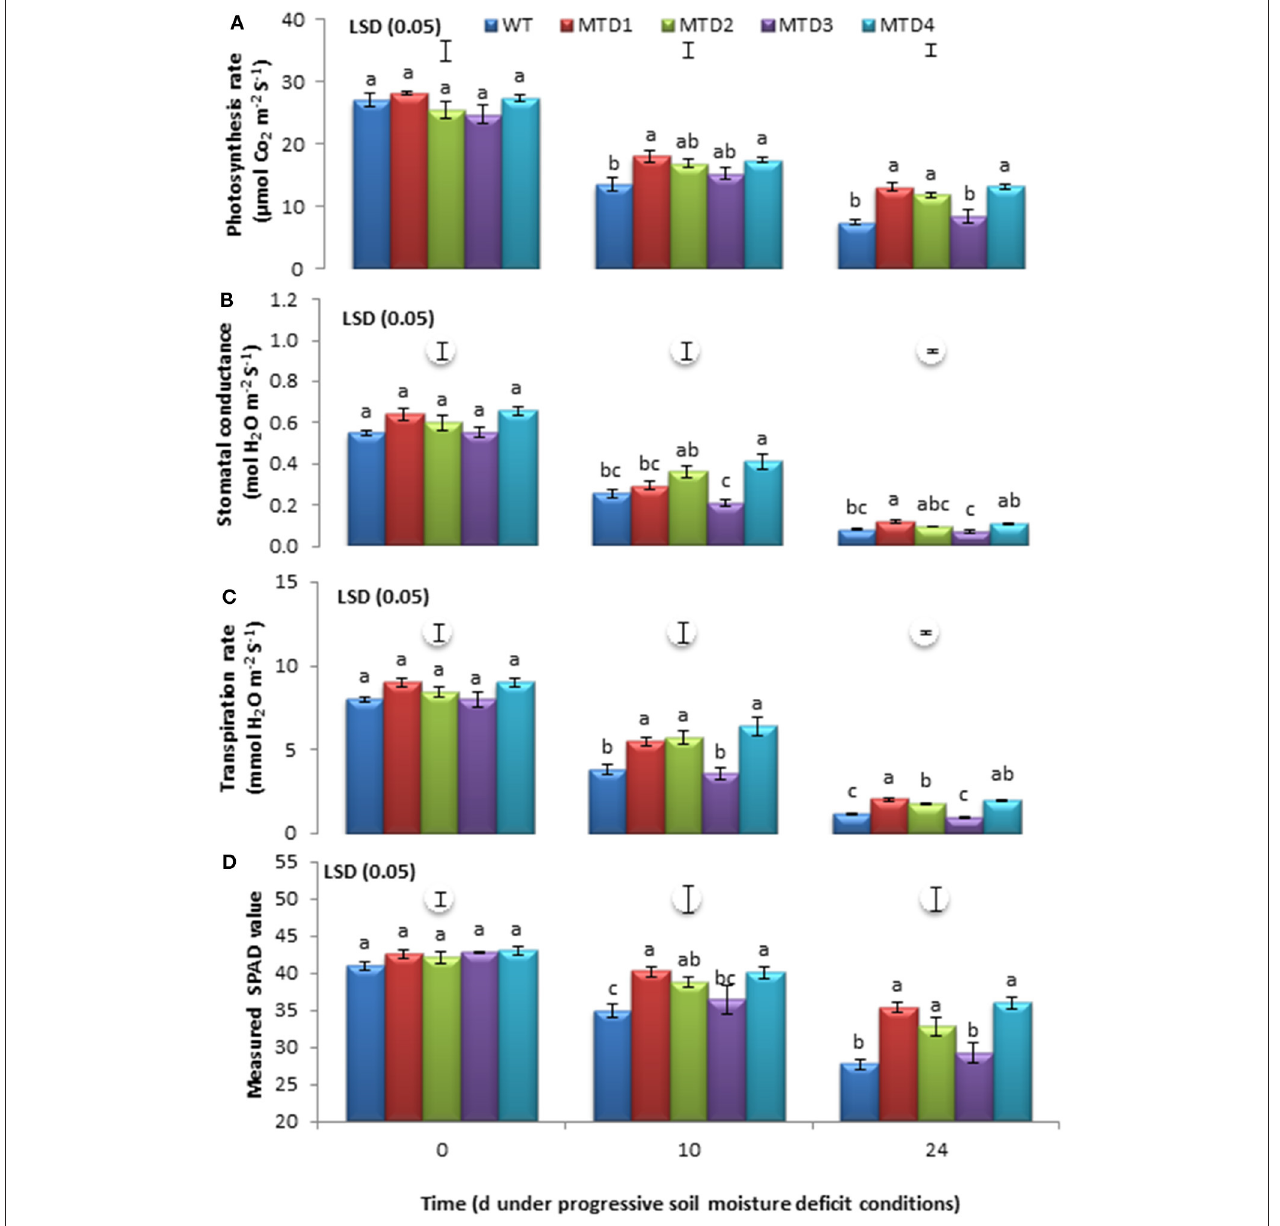
FIGURE 1 | Estimation of photosynthetic rate (A) , stomatal conductance (B) , transpiration rate (C) , and SPAD values (D) of wild-type and transgenic lines at 0, 10, and 24 days under drought-stress conditions. The mean values ± SE ( n = 3) followed by similar lower case letters within a column are not significantly different ( P ≤ 0.05).